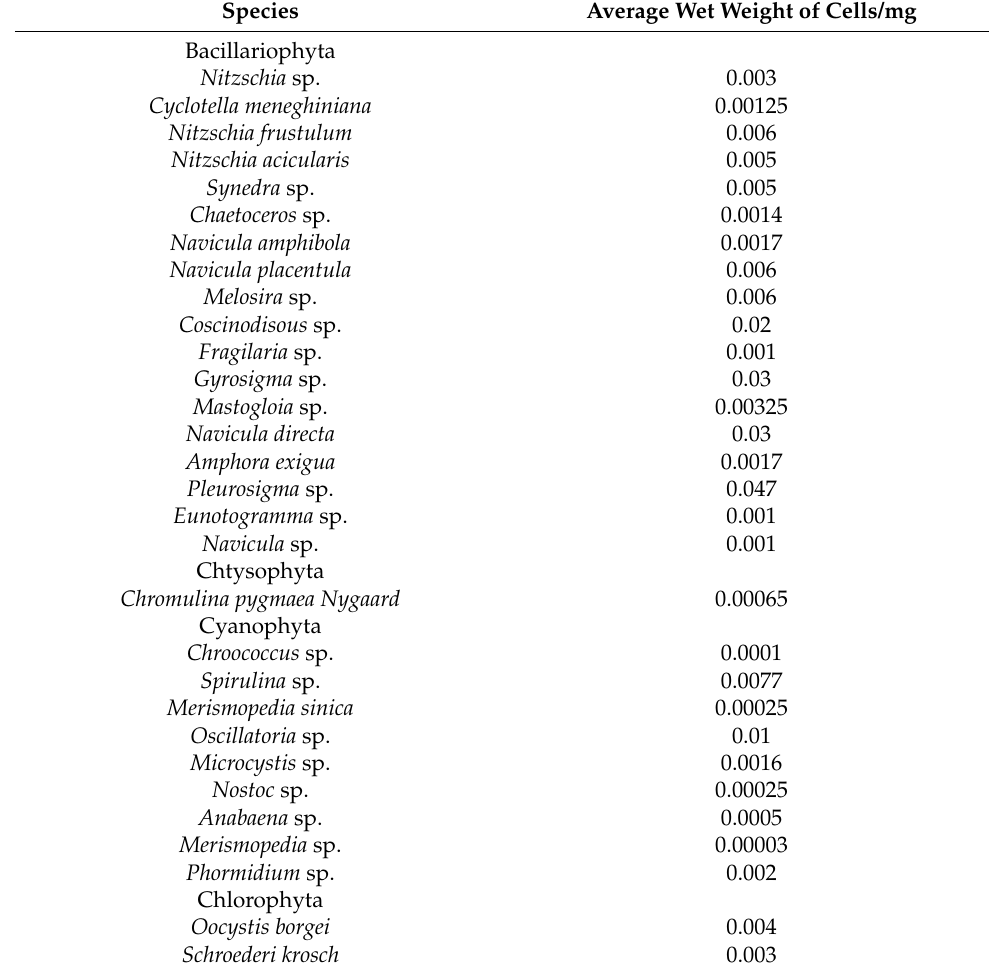
Table A2. Phytoplankton in each enclosure with the average wet weight. Species Average Wet Weight of Cells/mg